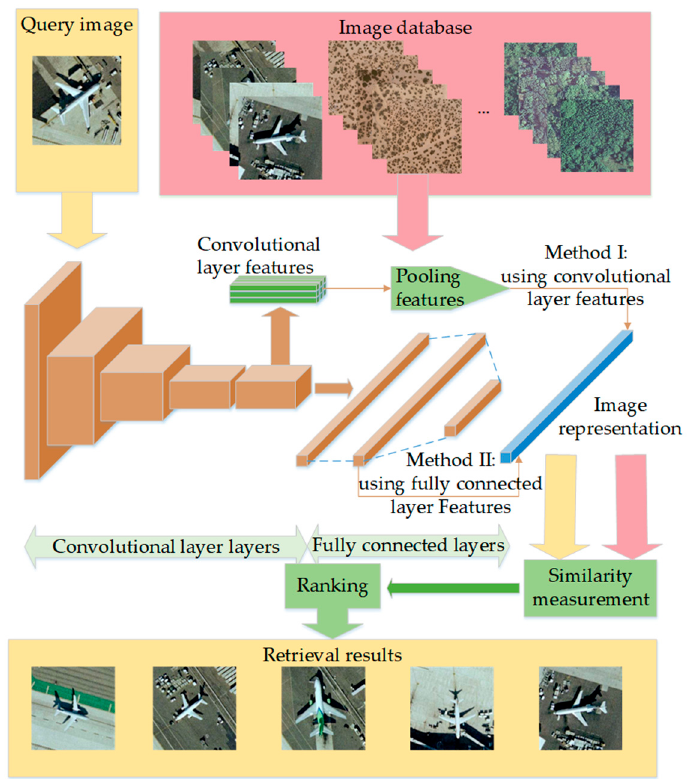
Figure 1. High-resolution remote sensing image retrieval (RSIR) framework based on convolutional neural network (CNN). The query image and image database are represented in the same method. First, the image representation is obtained from convolutional layer features or fully connected layer features. Then, the retrieval results are ranked by similarity measurement.